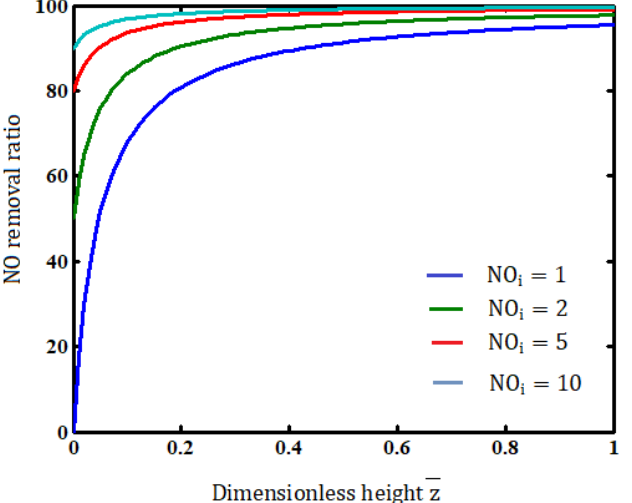
Figure 5. NOx removal T ratio NO R for various values of NO i . The experimental values of parameter [8] (Appendix C) are 𝛼 = 0.1121,𝛽 = 0.629,𝛾 = 0.0126, and 𝜂 = 10.5 , according to Equation (21).